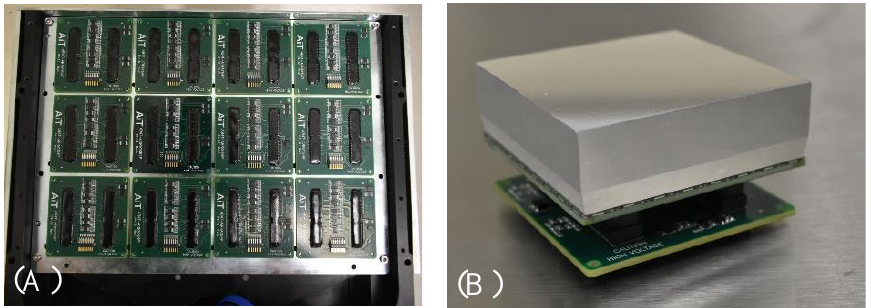
Figure 2. ( A ) Top view of 3 × 4 array of sensor modules inside a detector head; ( B ) photo of a block detector with the crystal array wrapped in a light-reflective material and an electronic board underneath.